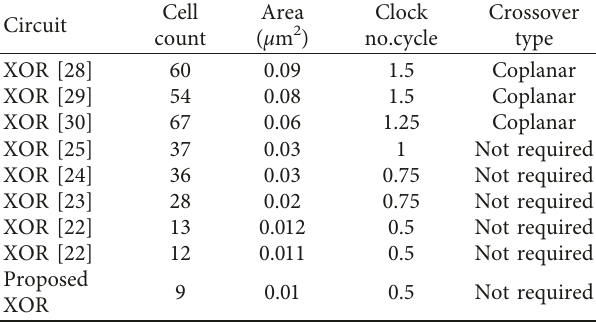
Table 1: Comparison of the proposed exclusive-OR gate with the previous work.